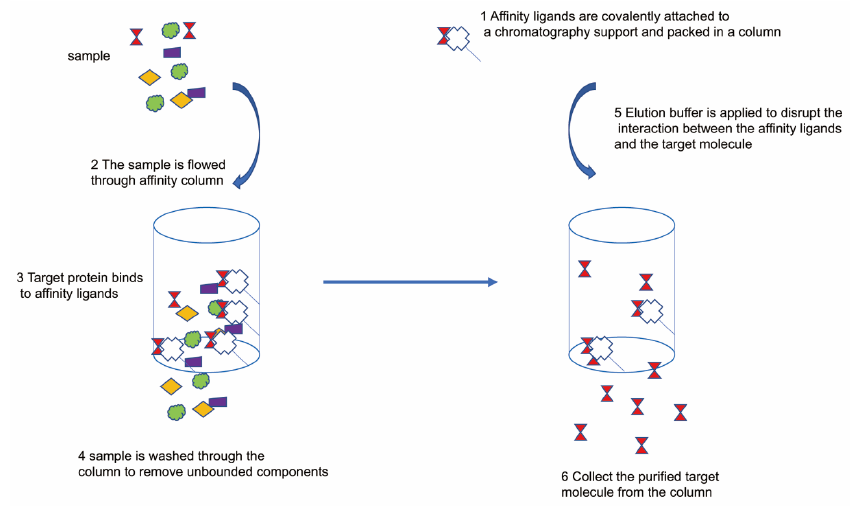
Figure 6. General protein purification process: protein of interest binds to column with resin, remove unbonded protein, and collect the target purified protein from the column by elution buffer.